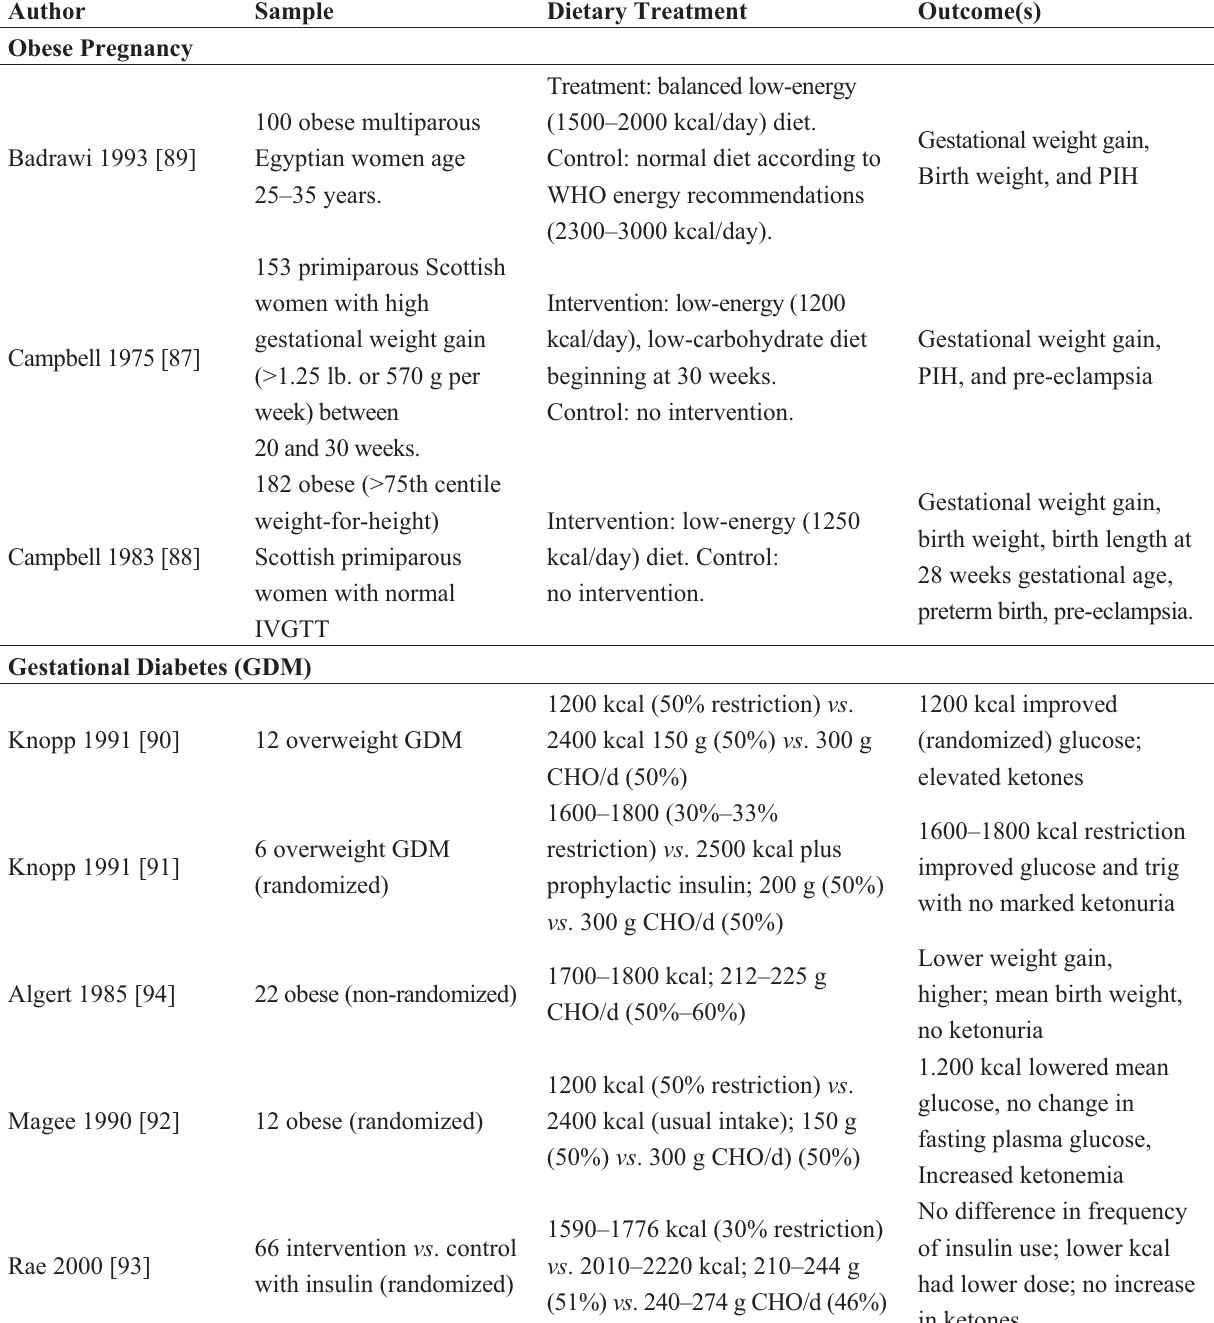
Table 4. Studies using hypocaloric antenatal diets for obese pregnancy and gestational